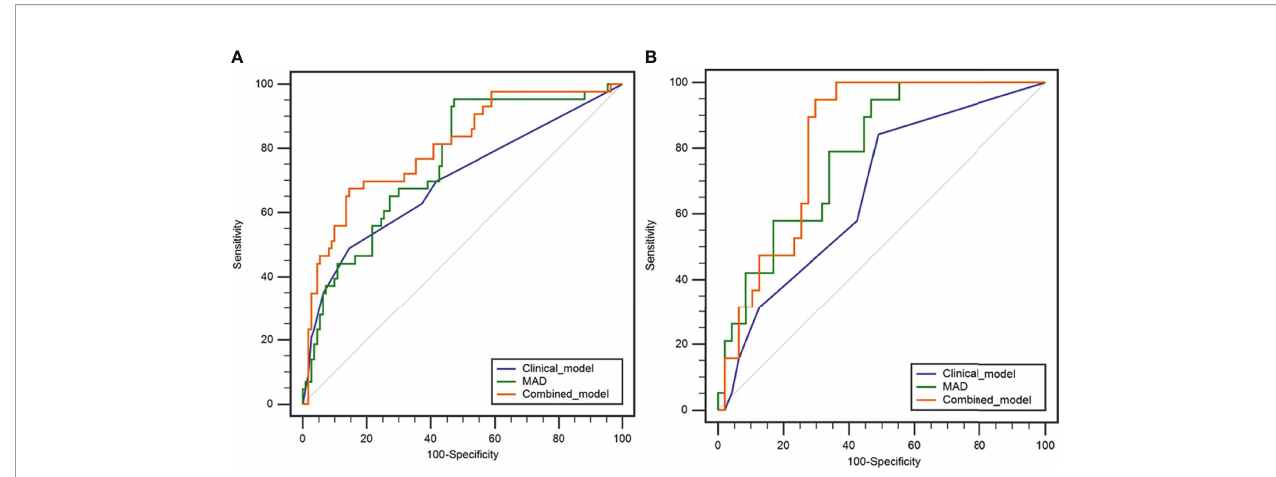
FIGURE 2 | Receiver operating characteristic curves of the clinical model, MAD, and combined model in predicting the early recurrence of LACSC treated with CCRT in the training cohort (A) and testing cohort (B)